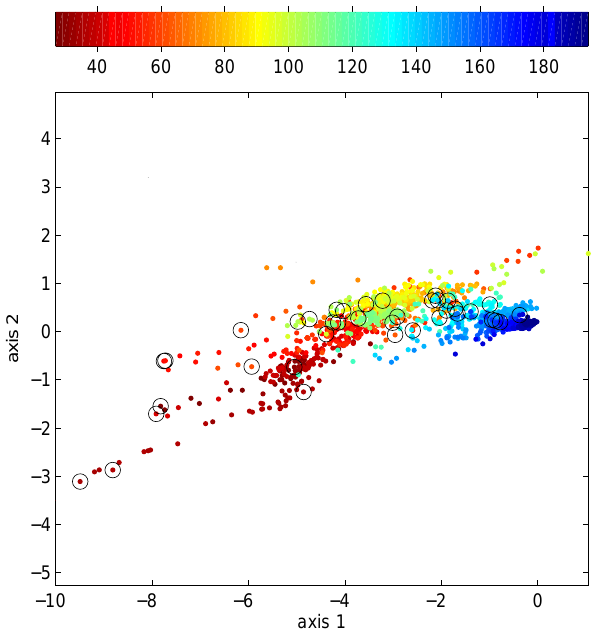
Fig. 4. 2-D map of the normalised fluxes. The distance between two points is indicative of the dissimilarity between the corresponding fluxes. The colour code corresponds to the wavelength in nm ; the 38 strong spectral lines that are labelled in Fig. 2 are circled. Axis 1 corresponds to W 1 f 1 (λ) and axis 2 to W 2 f 2 (λ)